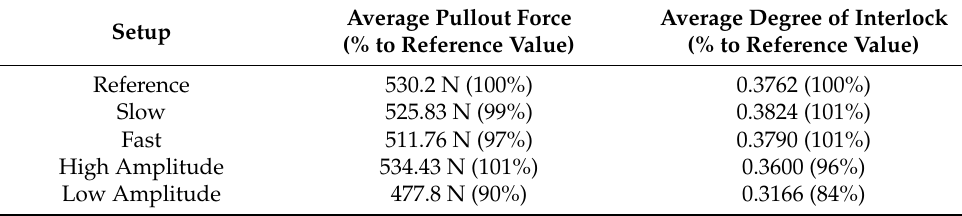
Table 2. Measured pullout forces and corresponding simulated average degree of interlock